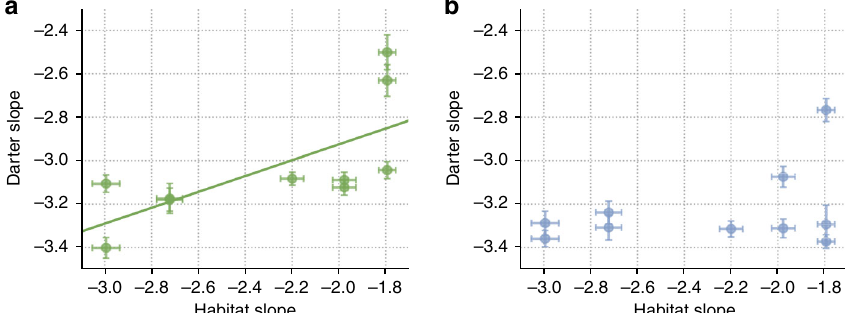
Fig. 5 Scatterplots comparing mean Fourier slopes of ten species of Etheostoma and of their habitats. a Males ( n = 288) and b females ( n = 262). For the males, E. pyrrhogaster and E. chlorosomum have nearly identical values, and appear superimposed on top of each other. This is also the case for E. camurum and E. blennioides . Error bars represent the standard